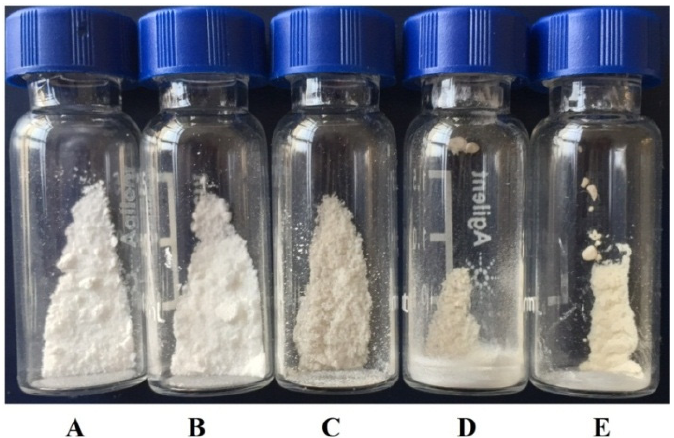
Figure 9. The photograph of SC4A samples before and after irradiation, irradiated dose: ( A ) 0 Gy; ( B ) 1.0 × 10 4 Gy; ( C ) 1.0 × 10 5 Gy; ( D ) 5.0 × 10 5 Gy; and ( E ) 1.1 × 10 6 Gy.